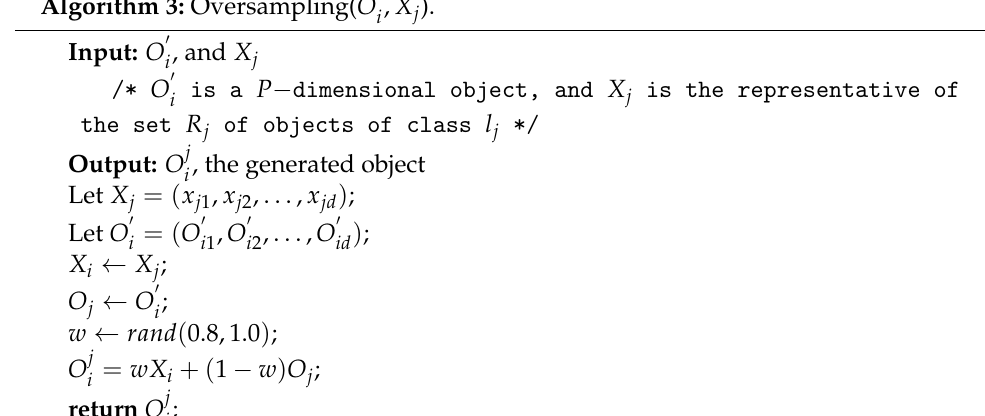
Algorithm 3: Oversampling( O